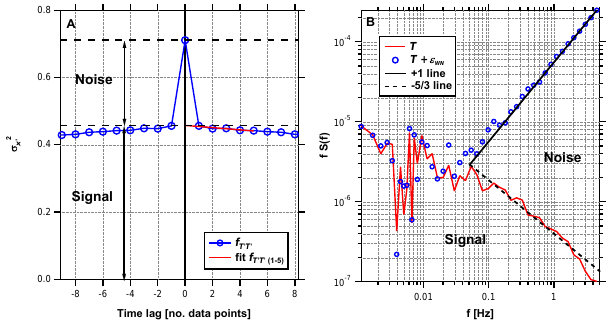
Figure 1. Illustration of the two methods for determination of anal- yser (temperature measurements, T ) variance attributable to un- structured white noise, through (a) the use of an auto-covariance function in the time domain and (b) from the variance power spec- tra in the frequency domain. Panel (a) shows how the first few points (points 1 to 5 in this example) of the auto-covariance function can be used to extrapolate the contributions of signal and noise compo- nents at a lag of zero (red